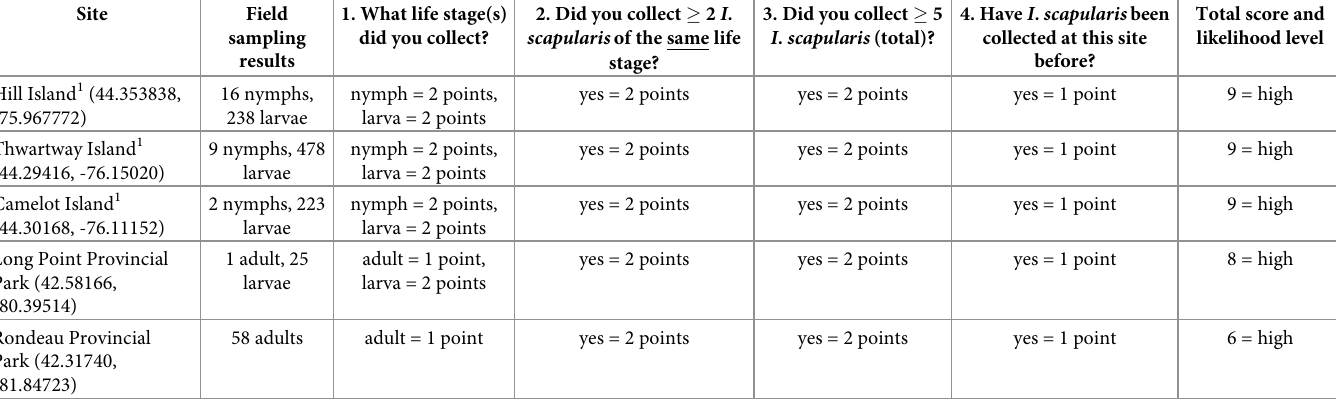
Table 2. Application of indicator. The scores based on the application of the indicator for five established sites in Ontario based on tick dragging in the summer and fall of 2013.